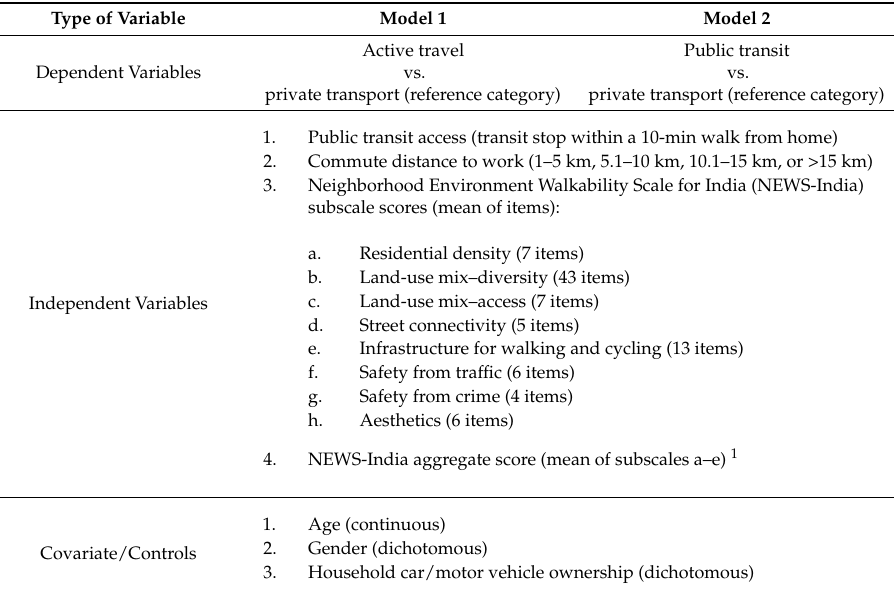
Table 2. Summary of variables used in multiple logistic regression models.